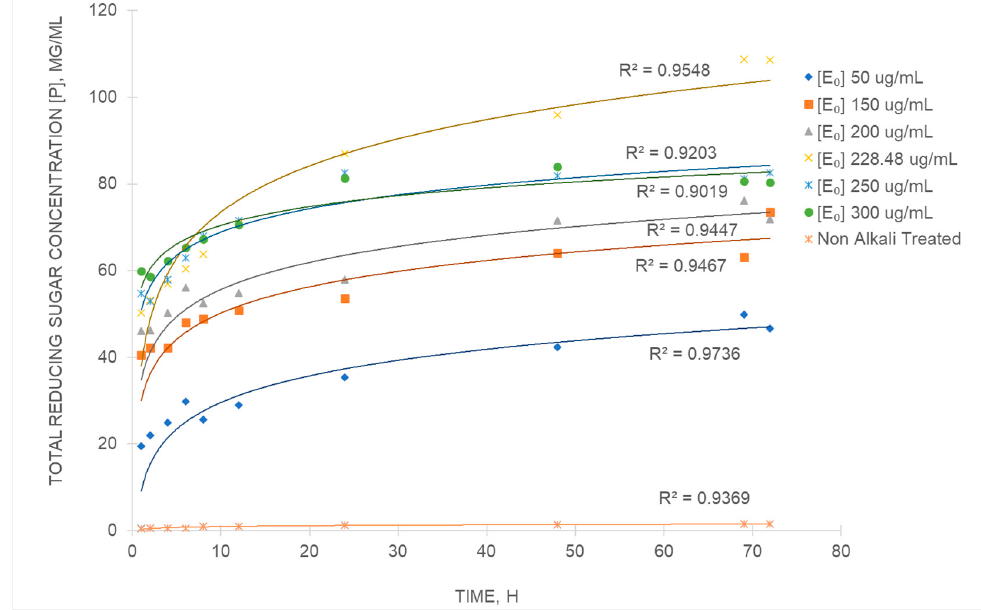
Figure 4. Enzymatic hydrolysis at 45 °C of treated PALF at various enzyme loadings (NaOH pre- treatment conditions: 2.43% ( w/v ) NaOH, a temperature of 87.22 °C, and a hydrolysis time of 57.15 min). The symbols represent experimental values, while the line curves represent the non-linear regression generated from the Chrastil model using Equation (4). E o = initial enzyme concentration. Table 4. Parameters based on empirical data regression.